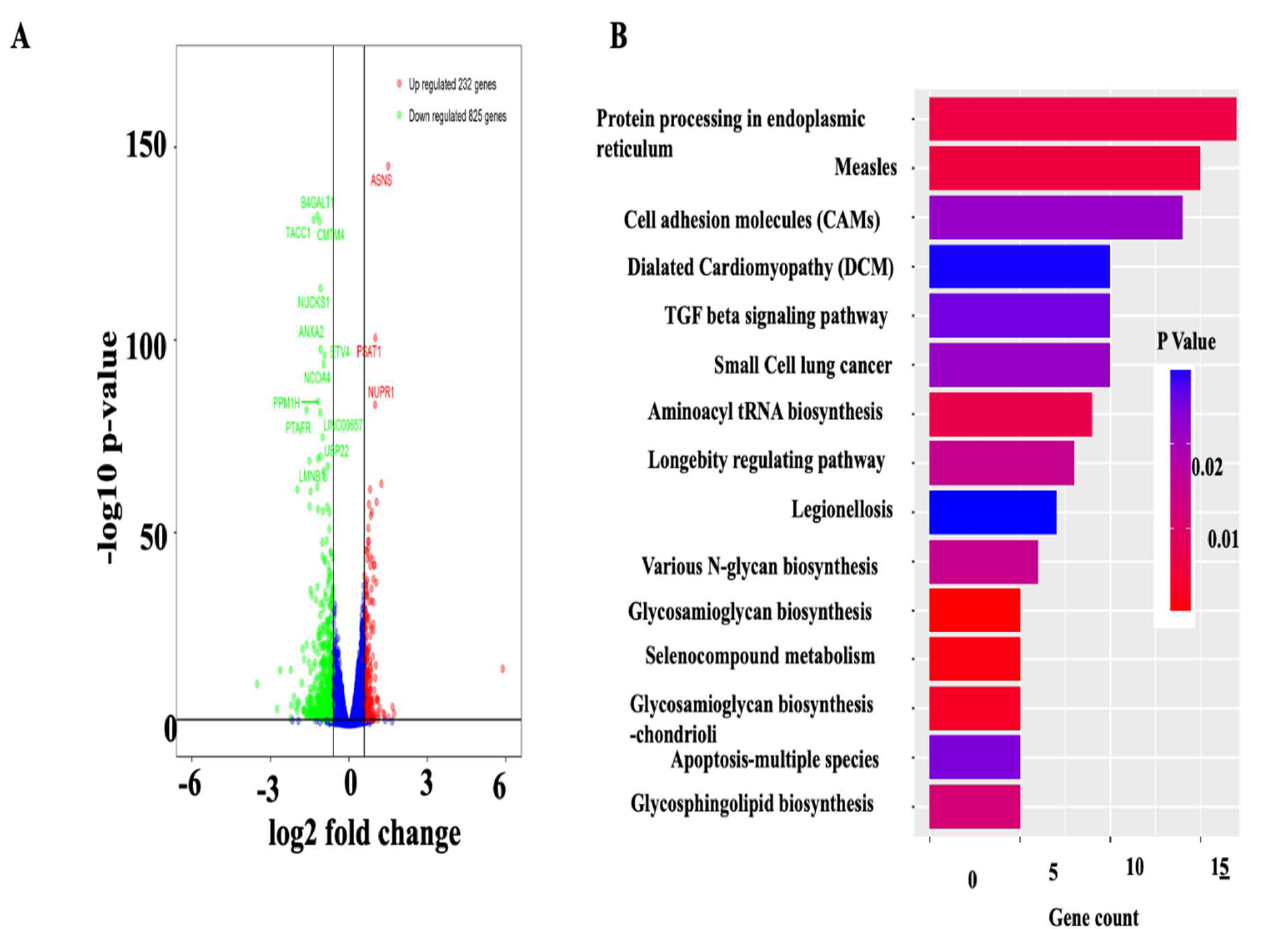
(Figure 5D,E) in CARF-depleted HepG2 cells. To substantiate this observation, we silenced CARF expression in AML12 cells and found that the expression of GRP78 and CHOP, but not IRE1a, increased in CARF-depleted AML12 cells (Figure 5F,G). We further found that overexpression of CARF blunted the palmitate-induced ER stress response in HepG2 cells (Figure 5H,I). Compared to vector-transfected control cells, the expression of IRE1 α , GRP78, and CHOP was much lower in CARF-overexpressed HepG2 cells. To determine whether deficiency of CARF induces chronic ER stress leading to hepatic steatosis, we inhibited ER stress in CARF-depleted cells through treatment with TUDCA, a chemical chaperone capable of neutralizing ER stress [34,35]. Results shown in Figure 5J indicate that inhibition of ER stress through TUDCA reduced fat accumulation in CARF-depleted cells. In addition to the ER stress signaling pathway, genes associated with calcium signaling pathways were also affected (Supplementary Table S1), suggesting that ER function as a reservoir of Ca 2+ was compromised in CARF-depleted cells, which could also exacerbate ER stress. Collectively, these findings suggest that deficiency of CARF activates chronic ER stress response, leading to lipogenesis in HepG2 cells.